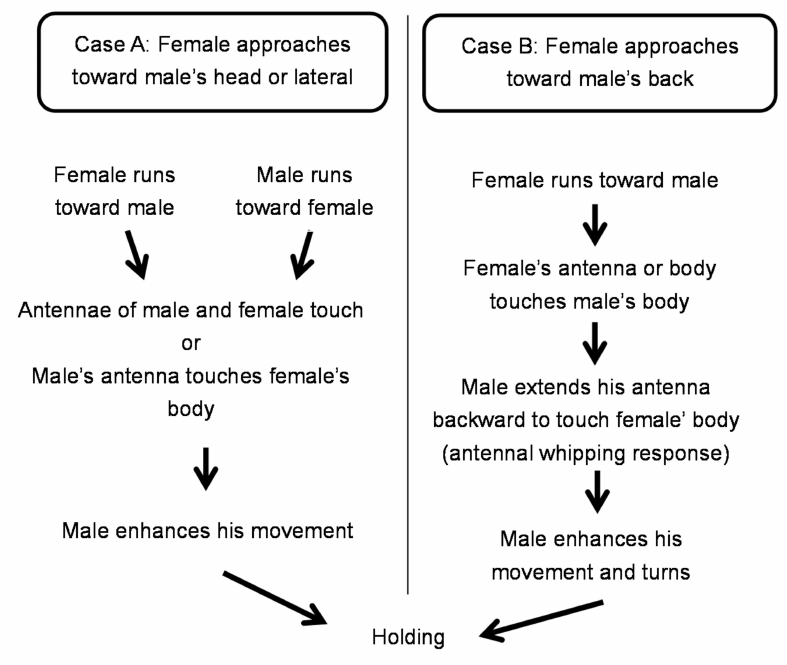
Figure 7. Ethogram of Rosalia batesi male and female toward mating.